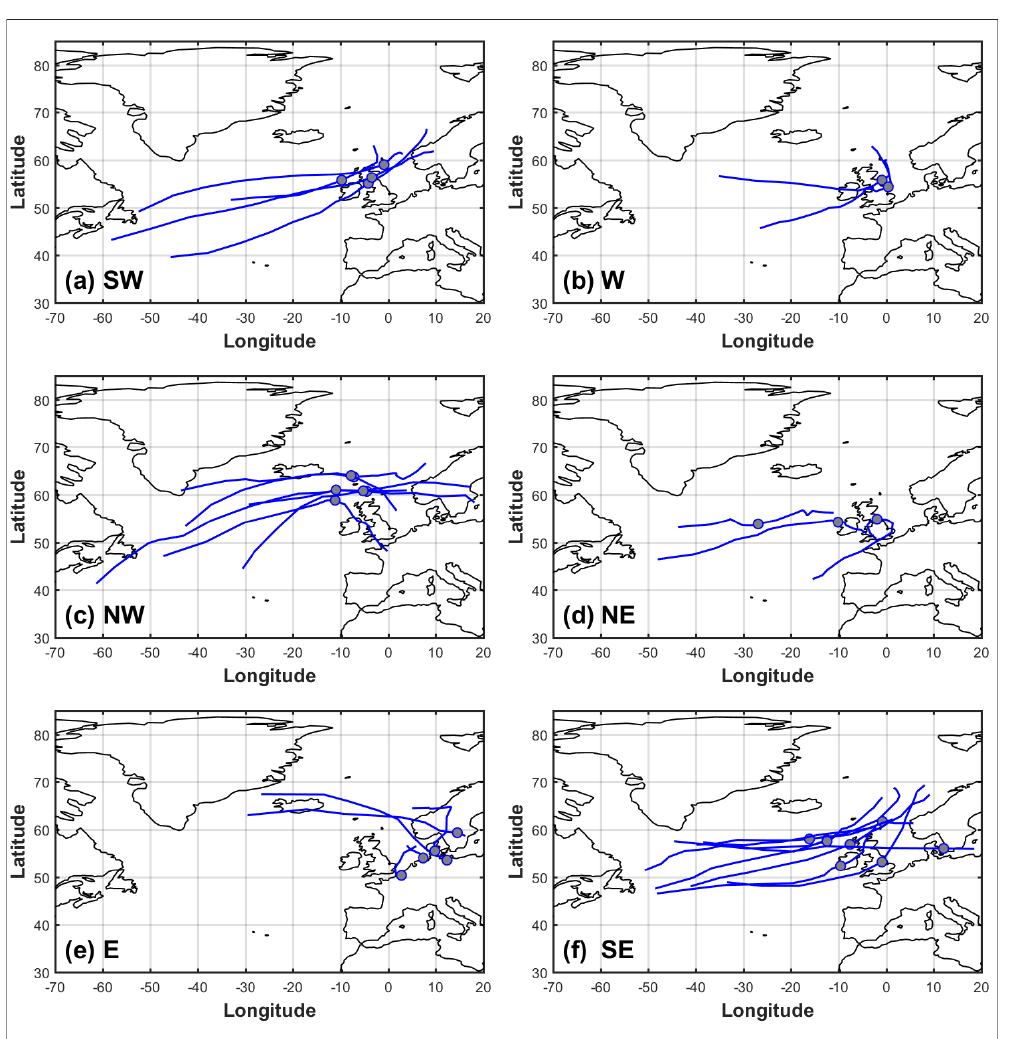
Figure 6. Storm tracks that generated the extreme wave events shown in Figure 5 for the distinct six regions identified: ( a ) SW region; ( b ) W region; ( c ) NW region; ( d ) NE region; ( e ) E region; and ( f ) SE region. The grey dots indicate where the storm centers were when the maximum significant wave height occurred.